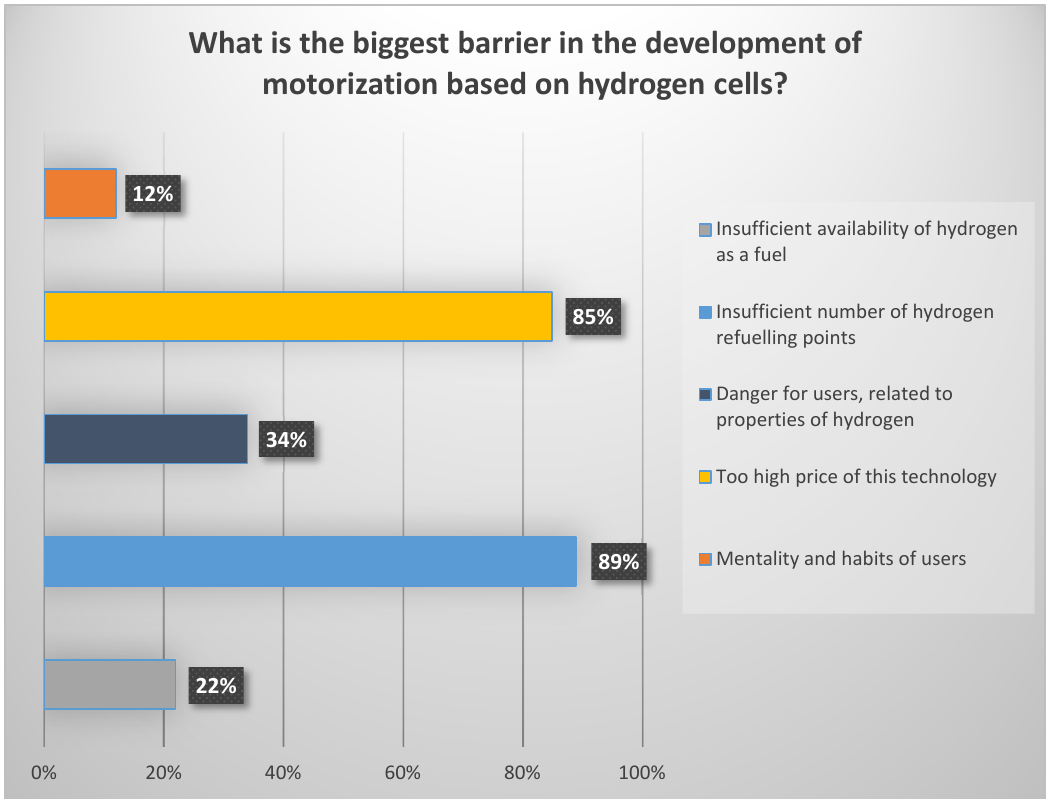
Figure 8. Survey question number 8. Source: own study.